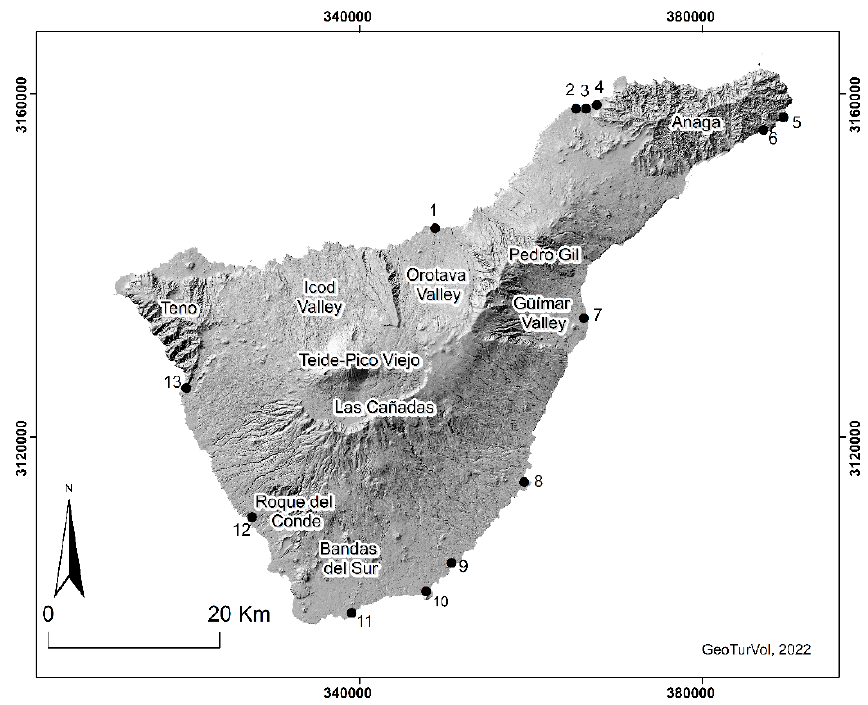
Figure 3. Aeolian sedimentary systems of this study. 1. Puerto de La Cruz; 2. Jover; 3. Milán; 4. Bajamar; 5. Antequera; 6. Igueste de San Andr é s; 7. Malpa í s de Gü í mar; 8. Punta de Abona; 9. Montaña Pelada; 10. El M é dano-Montaña Roja; 11. Montaña Amarilla; 12. La Caleta; 13. Los Gigantes. Source: self-elaboration based on the DEM of Table 2. The relative importance of aeolian landforms in the study area and their protection. P: present landform, F: frequent landform, A: abundant land form. The grey colour shows the presence of the item. Self-elaboration from fieldwork.